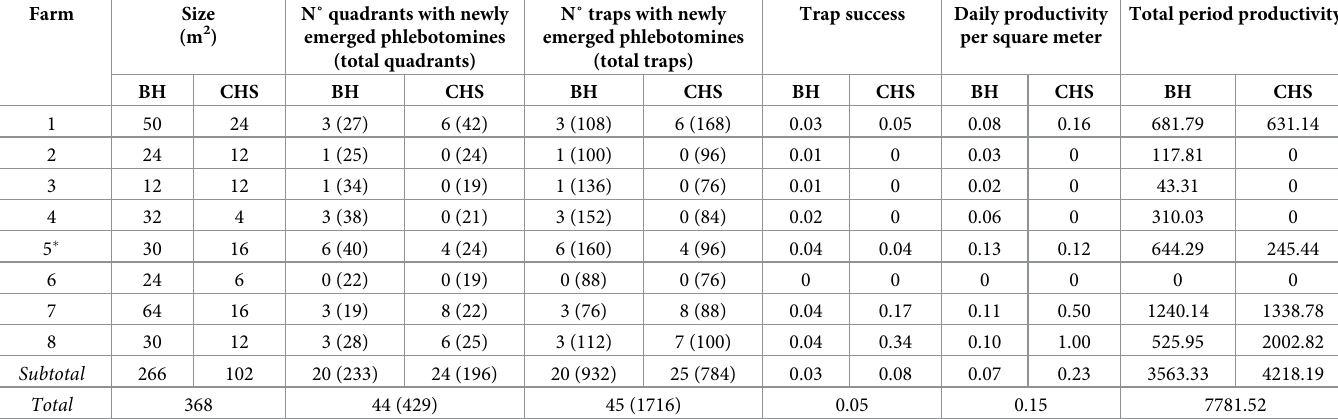
quinquefer (Dyar) (0.20%), Pi . fischeri (Pinto), Ev . cortellezzii and Py . monticola (the three spe- cies accounting for 0.06%). The latter three species were not captured in the house environ- ment. Regarding the association between abundances of newly emerged and adult Table 3. Second collection period . Capture of newly emerged phlebotomines in below house (BH) and chicken shed (CHS) environments in eight farms, from 21 st Octo- ber 2015 to 6 th April 2016 (4 cycles, 167 nights): Size of each environment (Size, m 2 ), Number of quadrants with newly emerged phlebotomines (number of sampled soil quadrants in each environment where at least one phlebotomine emerged); Number of traps with newly emerged phlebotomines (total number of traps set in each environ- ment where at least one phlebotomine emerged), trap success (number of newly emerged phlebotomines/number of traps), daily productivity of each environment (num- ber of newly emerged phlebotomines/m 2 /day) and total period productivity (number of newly emerged phlebotomines on the total area of each environment on each farm for the total collection